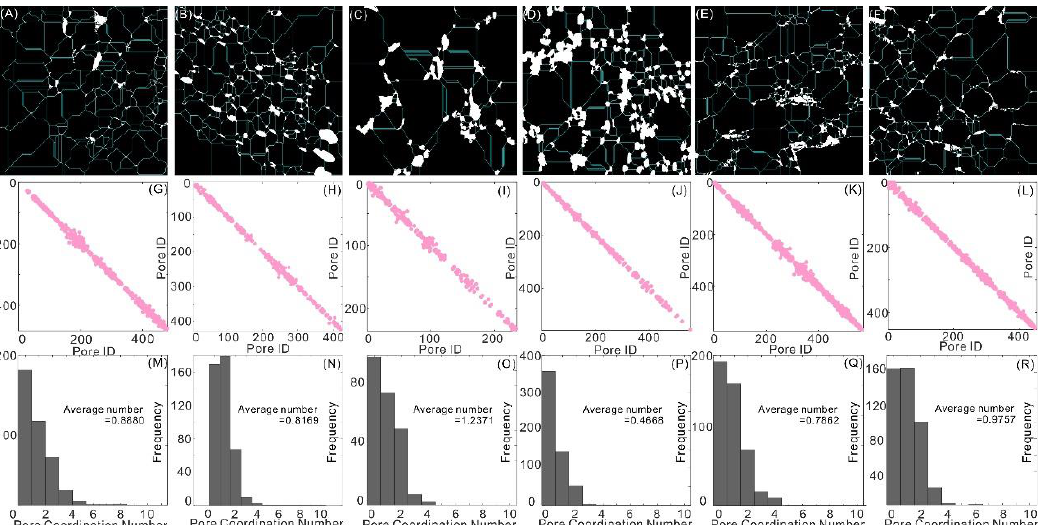
Figure 8. Coordination distribution of different types of pores in Figure 2 ( A – F ); Coordination re- sults of pore units between pore IDs of Figure 6 ( G – L ); Pore-throat coordination number distribu- tion of Figure 9G – L ( M – R